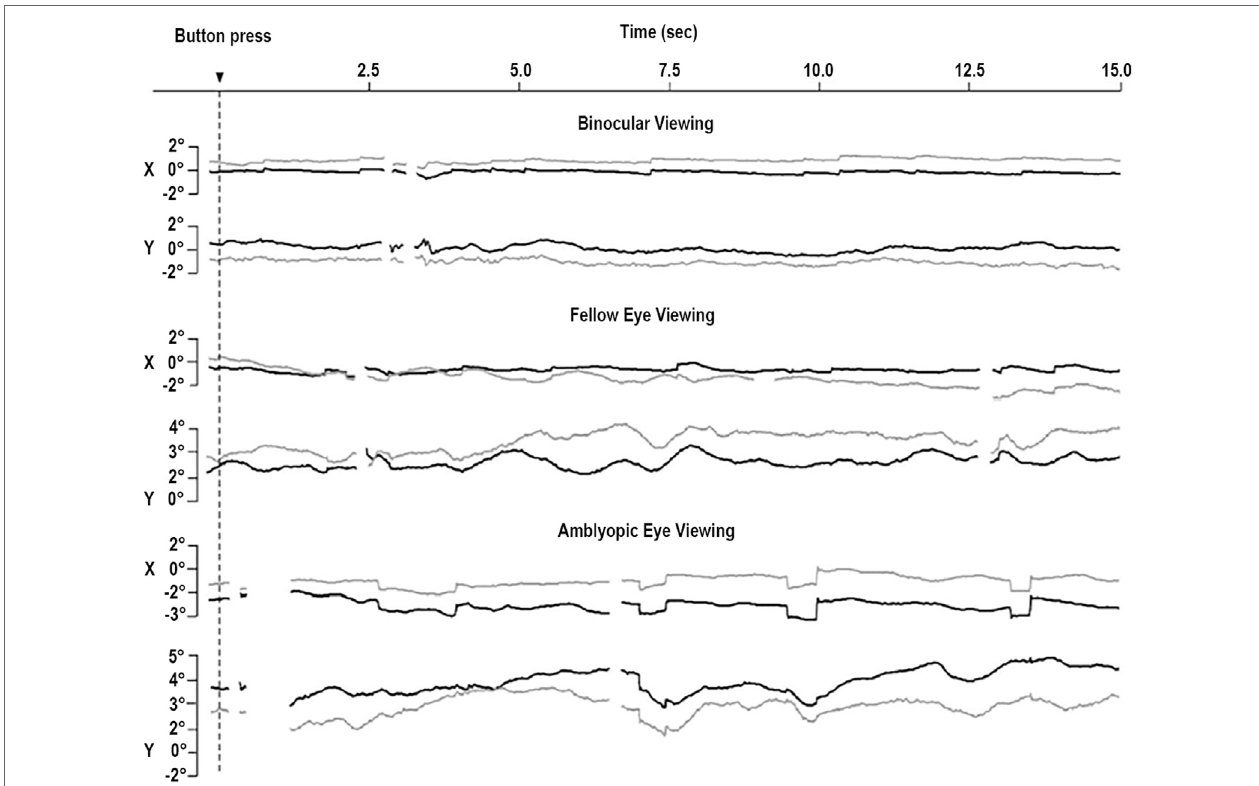
FigURe 3 | Eye movements of a patient with strabismic amblyopia. Horizontal ( X ) and vertical ( Y ) positions are plotted for the left eye (gray, amblyopic eye) and the right eye (black, fellow eye). Amblyopic eye viewing results in larger microsaccades in both eyes. Monocular viewing with the fellow eye is tied to increased instability in the amblyopic eye. Monocular viewing with the amblyopic eye produces increased instability in the two eyes. From González et al.